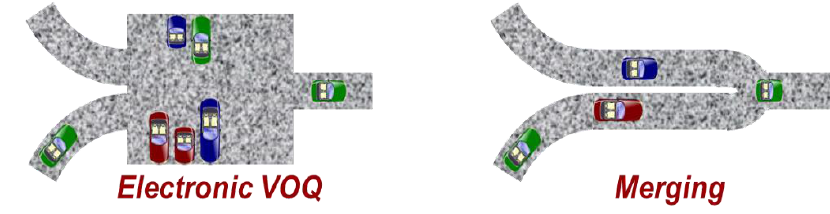
Figure 15. Electronic queues ( left , as in VOQ) use random-access storage, in which incoming packets are “parked” until removed (e.g., by a valet). Optical queues ( right ) can only slow down to avoid collisions, more like highway merging.